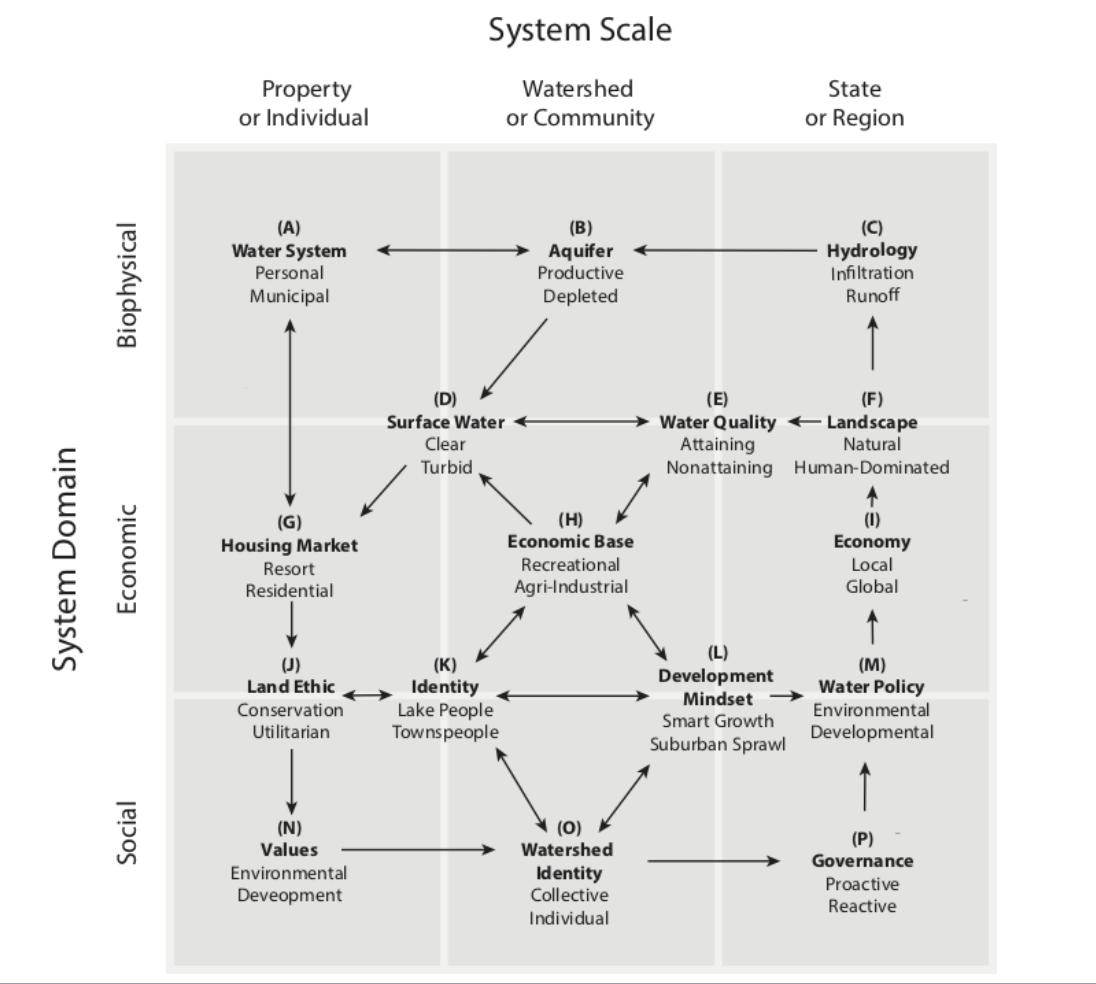
Fig. 2 . Threshold matrix with controlling variables placed at their respective scales and domains of